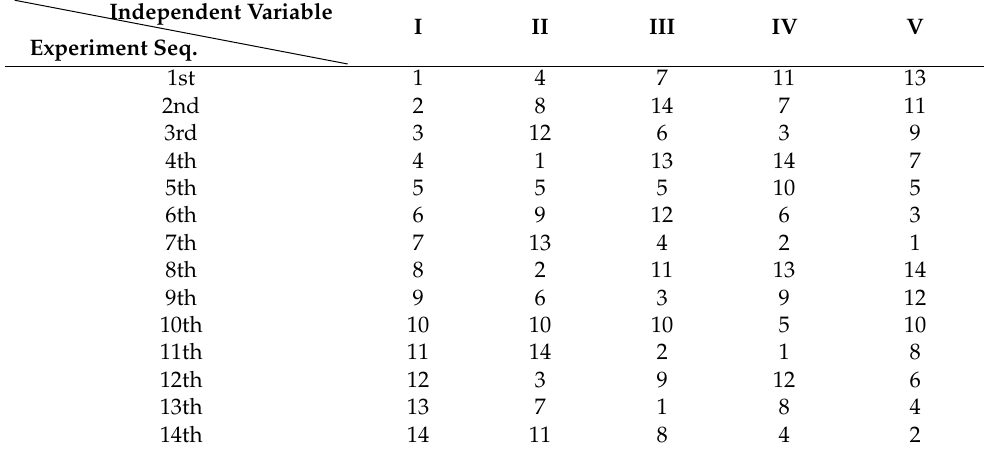
Table 1. Table of uniform design U 14 *(14 5 ).